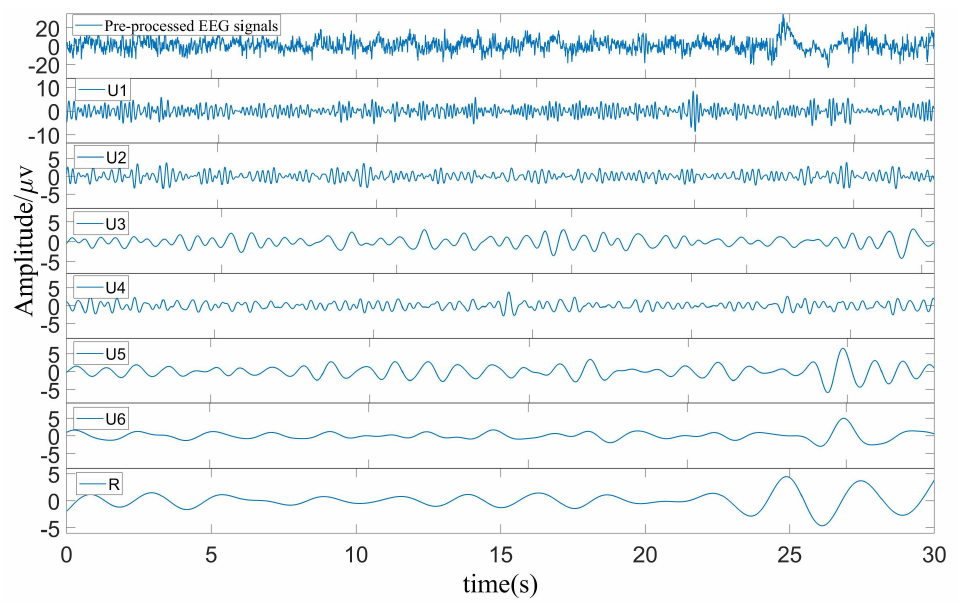
Figure 3. Decomposition of NSP after preprocessing of the 30-second EEG signal in the deep sleep